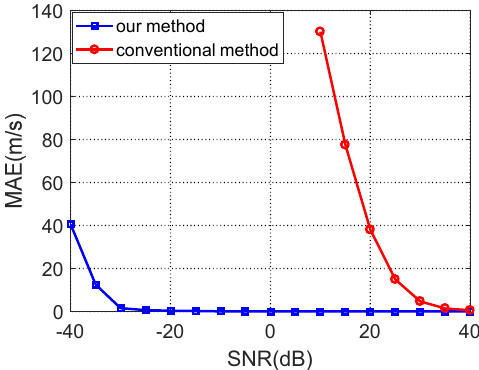
ff erent signal-to-noise Figure 9. The mean absolute error (MAE) under different signal-to-noise ratio. Figure 9. The mean absolute error (MAE) under di Figure 9. The mean absolute error (MAE) under different signal-to-noise ratio.